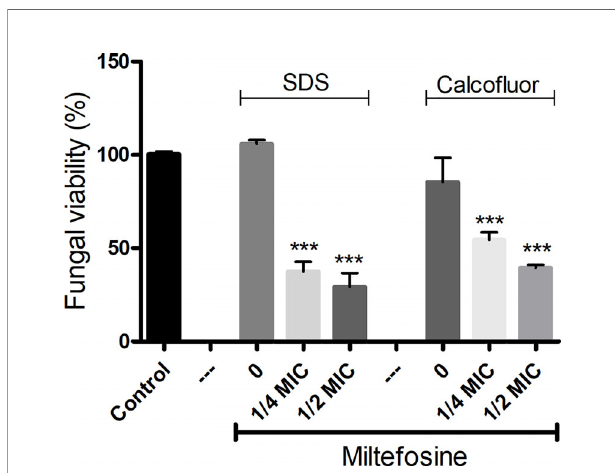
FIGURE 8 | Scedosporium aurantiacum susceptibility to membrane (SDS) and cell wall (calco fl uor white) stressors in the presence of miltefosine. The control represents fungal viability in the absence of stressors and miltefosine. SDS, sodium dodecyl sulphate. *** p < 0.001.